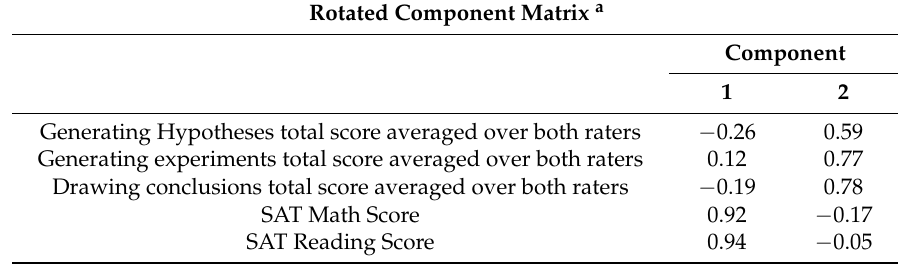
Table 5. Rotated principal component matrix in the Study 1 analysis of the total scores of our subscales and SAT scores.